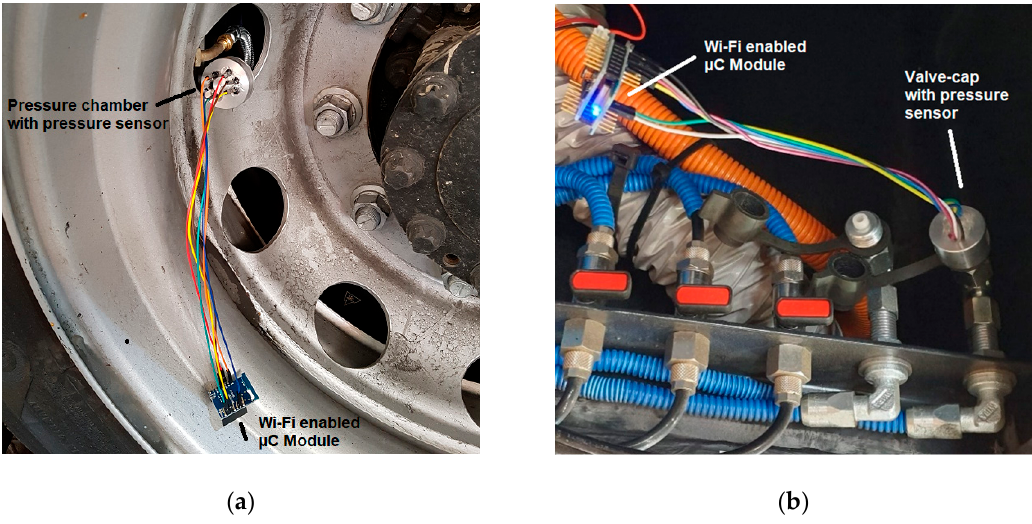
Figure 5. Attached Sensor Prototypes. ( a ) Tire Sensor. ( b ) Air Suspension Sensor.